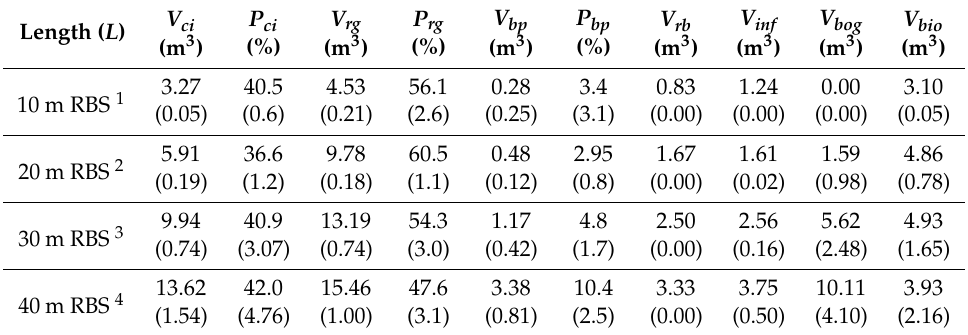
Table 6. Mean and standard deviation (numbers inside brackets) of parameters calculated from each of the five road-bioretention cases with the same L (10 m–40